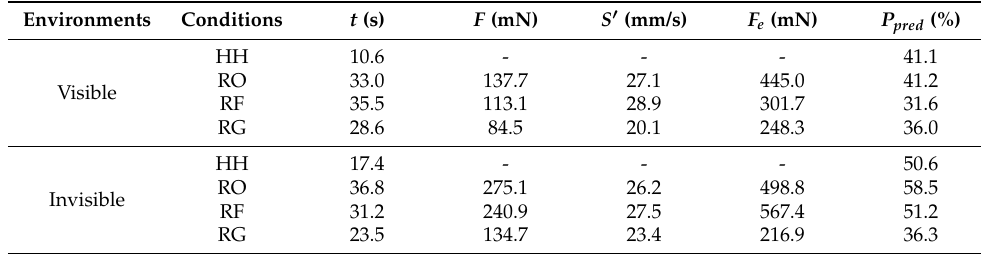
Table 3. The result of system